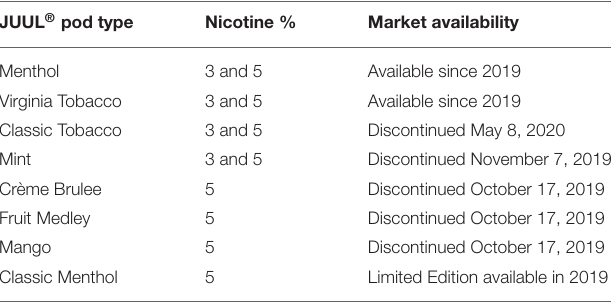
TABLE 1 | Details of 12 JUUL ® pod types used in this